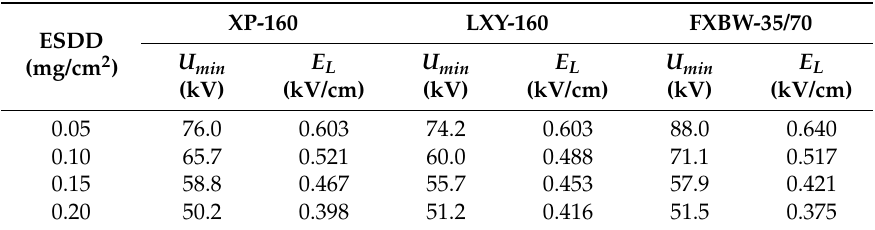
Table 4. Direct current (DC) arc flashover gradient of snow-covered insulators under different ESDD.